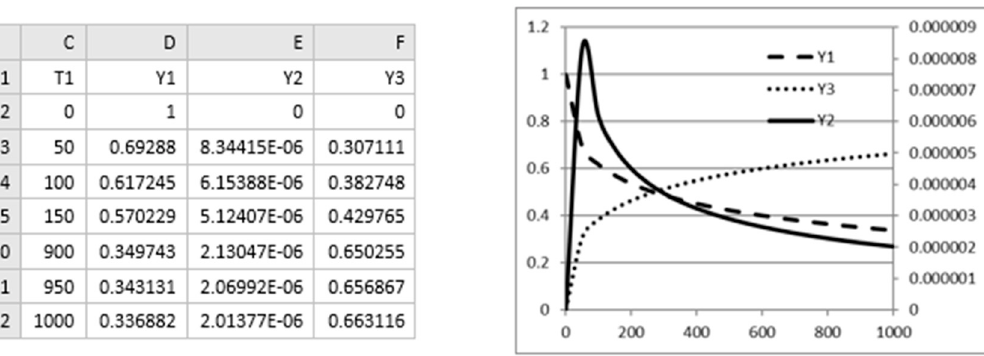
Figure A3 . Demonstration of QUADF for computing integral (A3) in Excel.